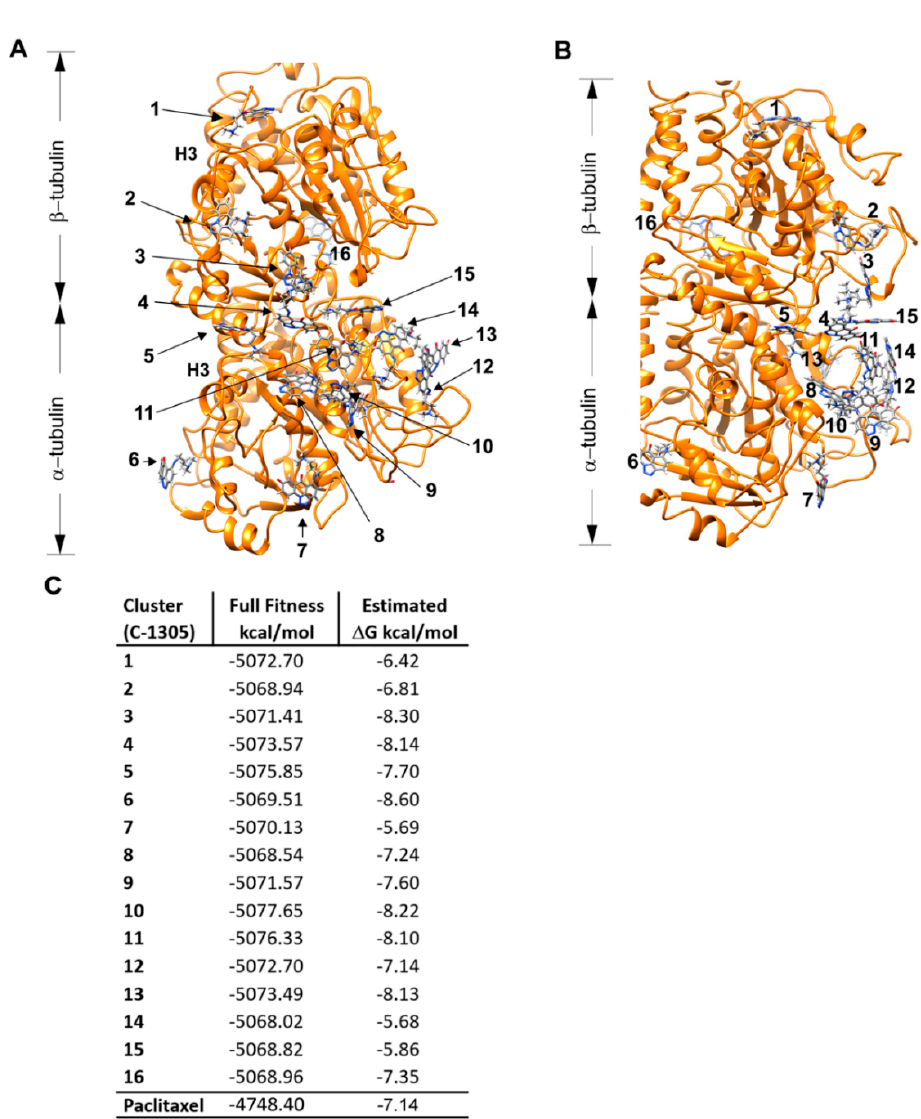
Figure 5. Molecular docking identifies potential C-1305 binding to the α / β tubulin dimer. ( A ) Predicted interactions between tubulin dimer and a C-1305 molecule. The favorable binding sites were identified by judging from the largest number of conformations in the same position with the lowest binding energy. The analysis showed minor di ff erences among the top results of each binding site for C-1305, supporting the robustness of the calculations. Additionally, the superposition of the structure of